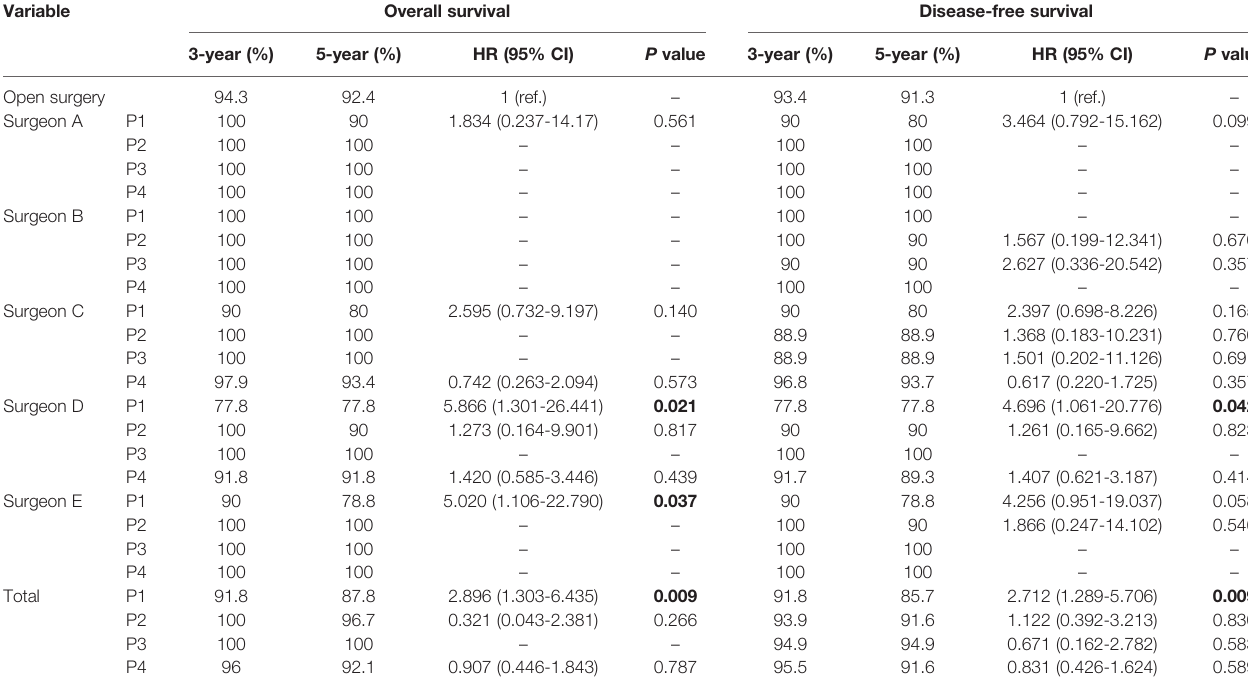
TABLE 2 | Survival outcomes of different surgeons in different phases in minimally invasive surgery.